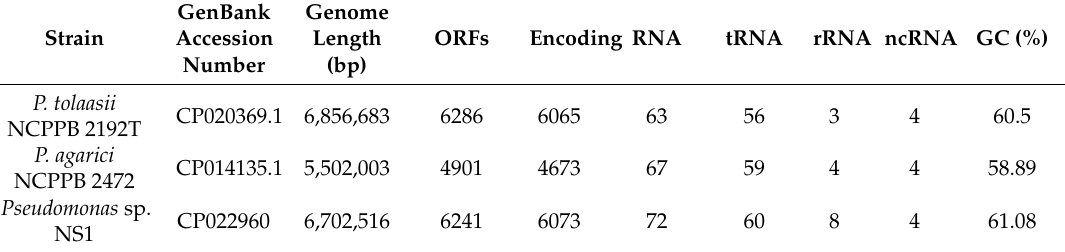
Table 1. Whole genome sequence characteristics of bacteria used in this